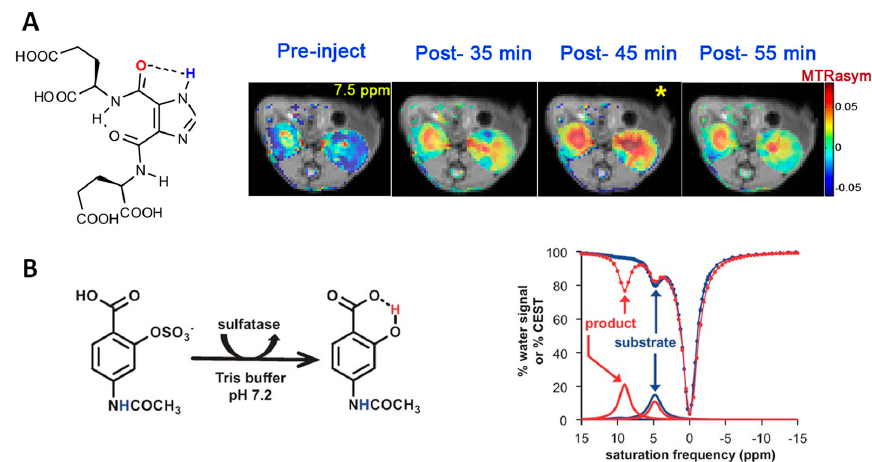
Figure 10. ( A ) The chemical structure imidazole-4,5-dicarboxamide, a diaCEST pH sensor (left), and in vivo kidney pH maps (right). Adapted with permission from [83]. ( B ) CatalyCEST MRI of sulfatase activity: (left) the aryl sulfate ligand of compound 2 (referred to as the substrate) is cleaved by sulfatase, generating a salicylic acid moiety. The aryl amide ligand is not changed by the enzyme and the detection of sulfatase activity from mammalian cells. The CEST spectra before (blue) and after (red) incubation of the agent with HEK293 cell suspension showed the appearance of a CEST signal at δ = 9.0 ppm (right). Adapted with permission from [87].